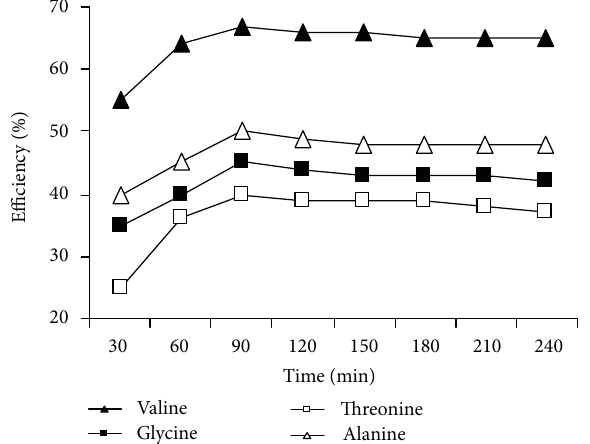
F 5: Effect of time on extraction of amino acid with krypto�x 5. Concentration of amino acid in source phase =